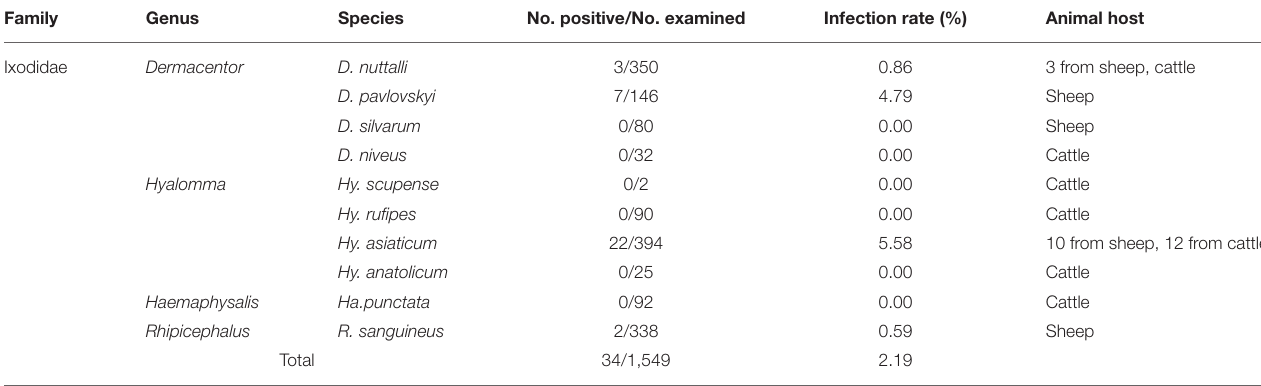
TABLE 2 | The positive rate of Bartonella spp. in ticks was detected by ribC -PCR.